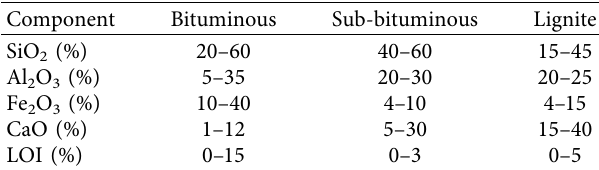
Table 2: Composition of various fy ashes.